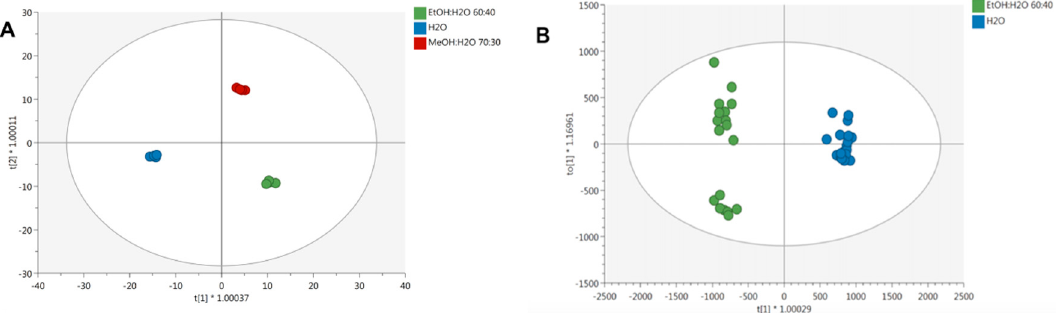
Figure 9. Orthogonal projection to latent structures discriminant analysis (OPLS-DA) on phenolic profiles of different lentil seed coat extracts, as a function of the solvent used ( A ) and solvent-extraction technique used ( B ). Individual replications are given in the class prediction model score plot.